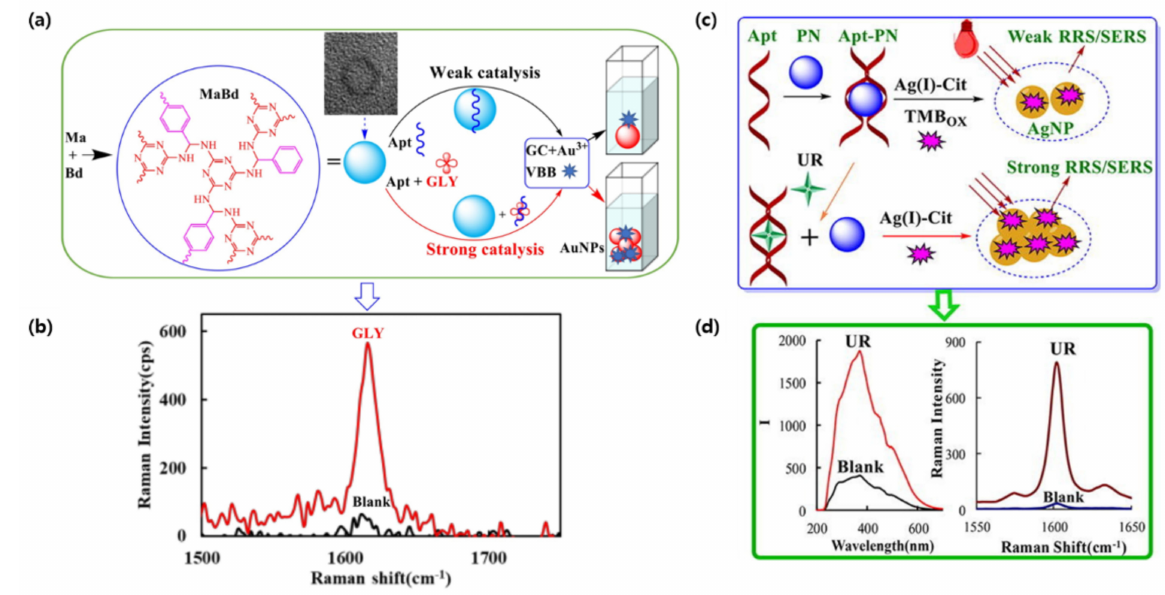
Figure 2. SERS aptameric catalysis mechanism: ( a ) Aptamer-mediated MaBd catalysis of GC-HAuCl4 nanogold reaction for the detection of glyphosate. ( b ) Raman spectra of glyphosate detection peak. ( c ) Aptamer-mediated PN-AgNO 3 -Cit catalytic amplification reaction for the detection of urea. ( d ) Raman spectra of RRS and SERS dual-mode urea detection. (Reproduced with permis- sion from [74], published by Elsevier 2021; reproduced with permission from [76], published by Elsevier